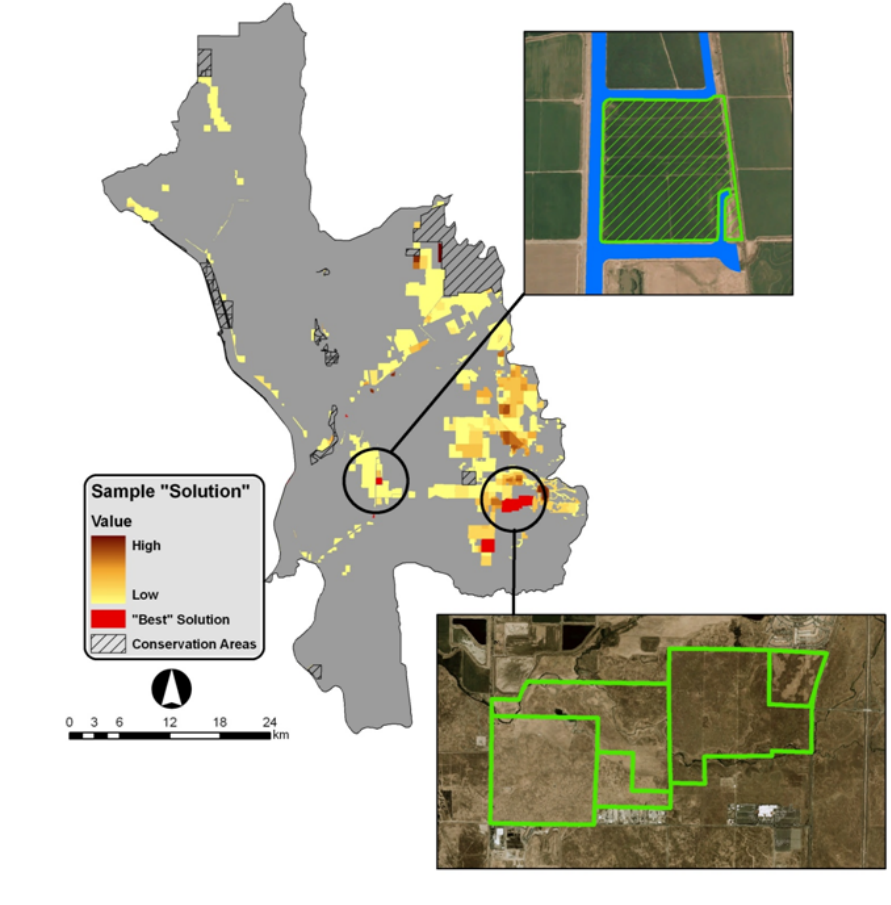
Fig. 6. Results from the MARXAN scenario showing possible mitigation-needs solutions for the Pleasant Grove area. In this scenario, all public lands and lands within the levee system are considered to be conservation areas. The darker-brown parcels are those selected often by MARXAN as potentially meeting Caltrans mitigation needs. A sample “best” MARXAN solution (red parcels meet mitigation obligations with a low cost) is shown, with two aerial imagery insets (NAIP 1-m resolution, USDA 2005). The top inset shows a selected rice field parcel that could potentially serve as T. gigas habitat whereas the lower inset shows five adjacent selected parcels that combine to form a portion of a grassland corridor (running east–west). These grassland parcels also potentially harbor vernal